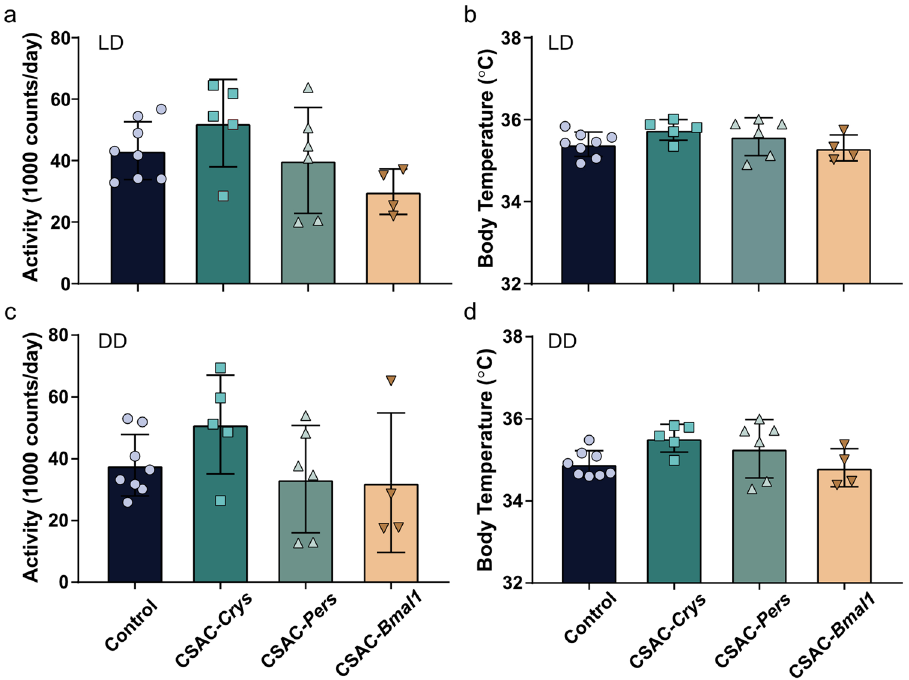
Figure 7. Average locomotor activity and body temperature. ( a ) Average locomotor activity under a 12:12-h light/dark (LD) cycle. ( b ) Average body temperature under an LD cycle. ( c ) Average locomotor activity